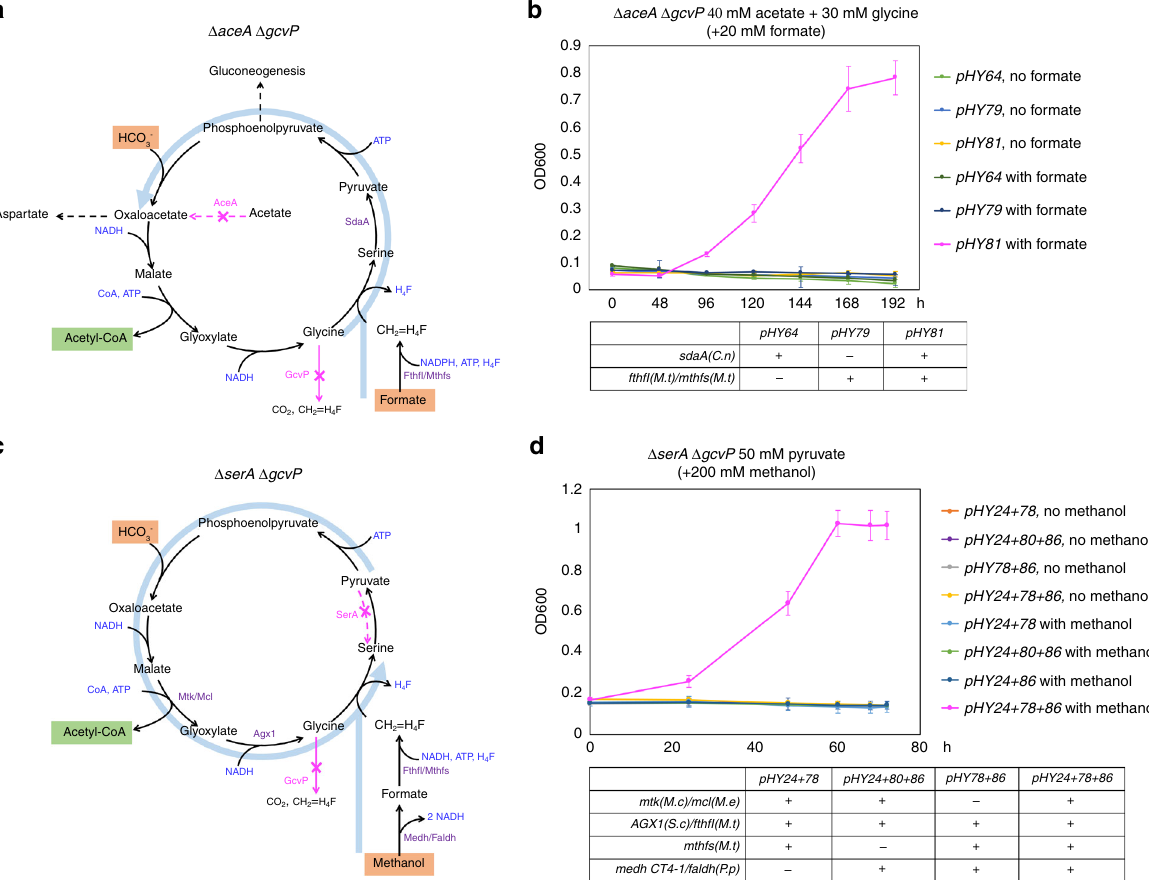
Fig. 3 Construction of the modi fi ed serine subpathway in E. coli . a , b Expression of sdaA ( C.n ), fth fl ( M.t ), and mthfs ( M.t ) could support the Δ aceA Δ gcvp strain to grow in minimal medium by using glycine/formate/acetate as carbon sources ( b ), which indicated the function of the modi fi ed serine subpathway marked as blue arrow in a . c , d Expression of a set of heterologous genes, including mtk ( M.c ), mcl ( M.e ), AGX1 ( S.c ), fth fl ( M.t ), mthfs ( M.t ), medh ( CT4 – 1 ), and faldh ( P.p ), allowed the Δ serA Δ gcvp strain to grow in minimal medium with pyruvate and methanol as carbon sources ( d ), which demonstrated the function of the modi fi ed serine subpathway marked as blue arrow in c . Error bars are s.d., n =